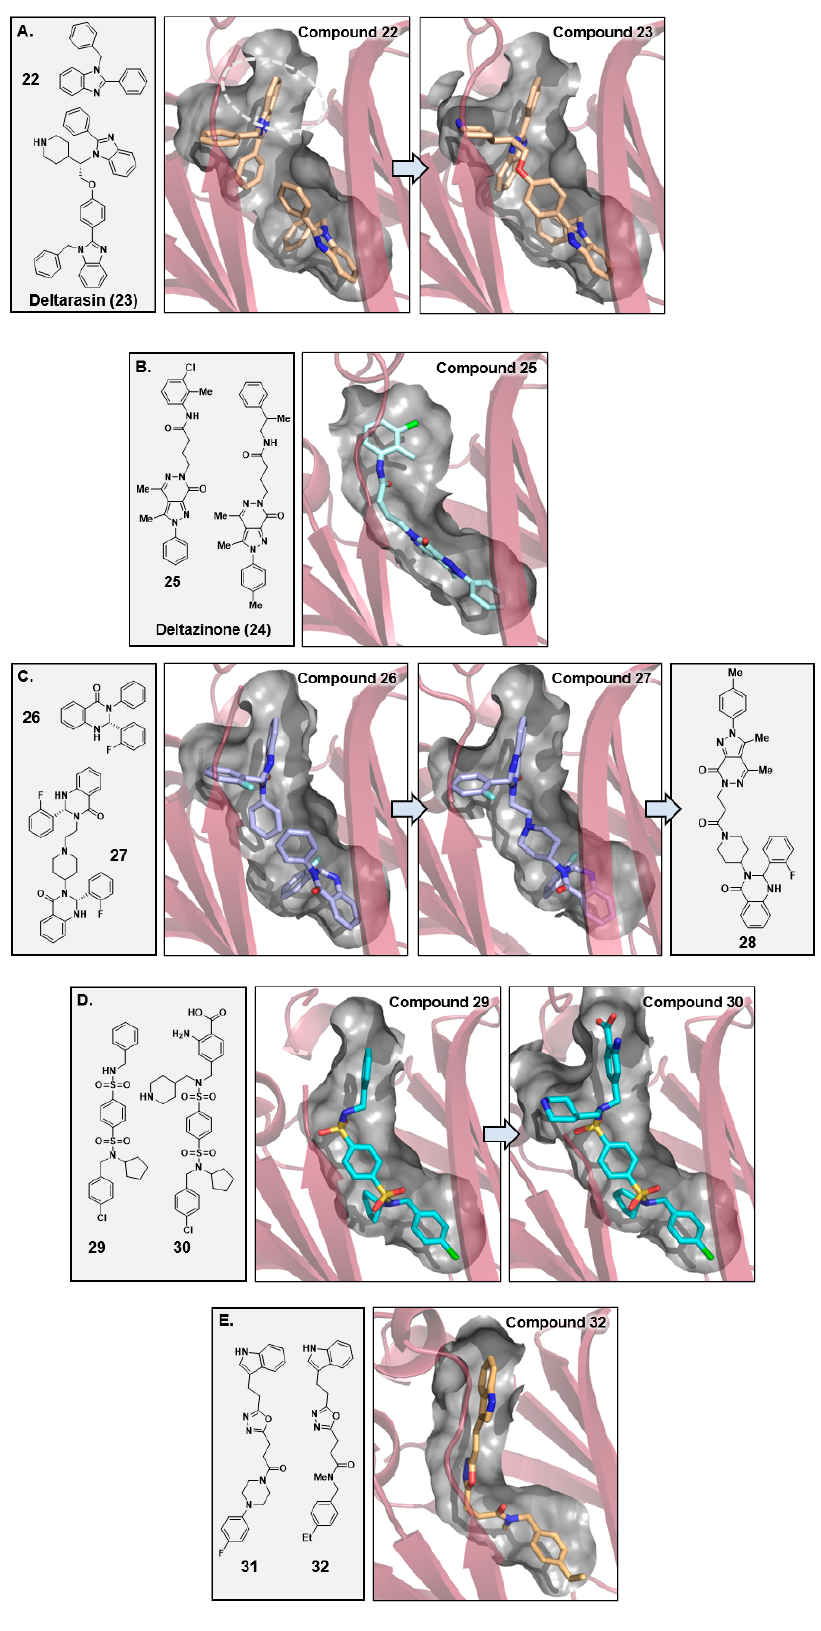
Figure 9. Multiple chemical series of PDE δ :RAS PPI inhibitors 22 – 32 (Figure 9 A – E ). In the molecular graphics, the inhibitors are shown in stick and the PDE δ protein is depicted as red ribbons. A partial surface of the PDE δ prenyl binding pocket (also see Figure 8) is shown in grey.